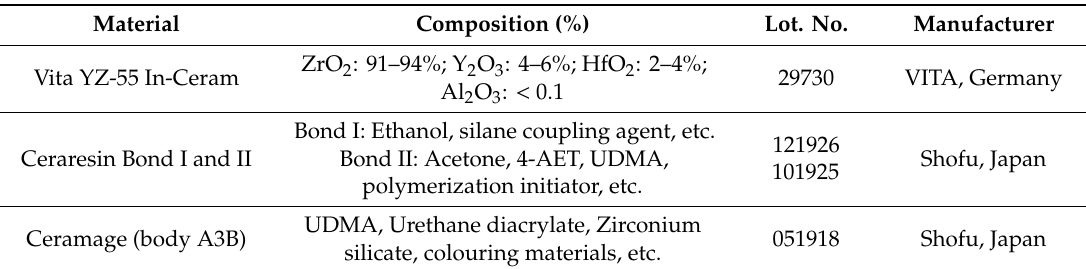
Table 1. The experimental materials used in this